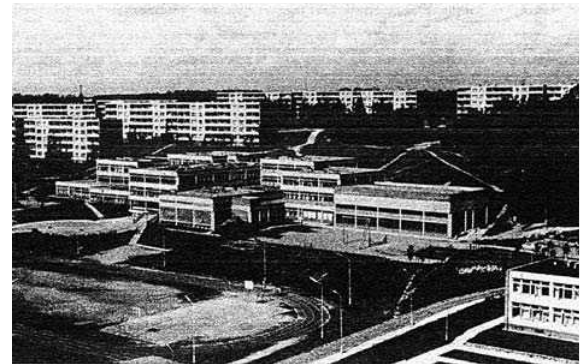
1974 m. Fig 6. 40th (now Minties) Secondary School in Vilnius, Lazdynai,